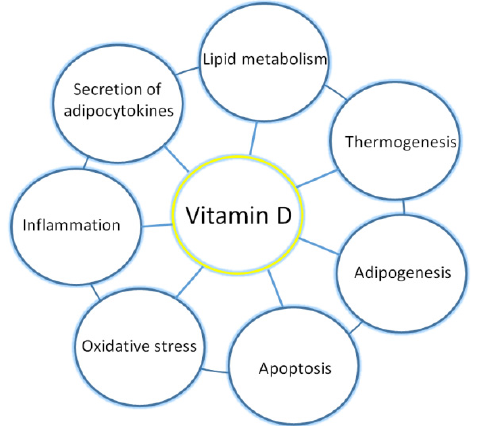
Figure 5. The role of vitamin D in adipose tissue. Vitamin D plays an important role regulating different signaling pathways and metabolic processes; adipogenesis, apoptosis, oxidative stress, inflammation, secretion of adipocytokines, lipid metabolism, and thermogenesis, contributing to its suitable functioning and homeostasis.